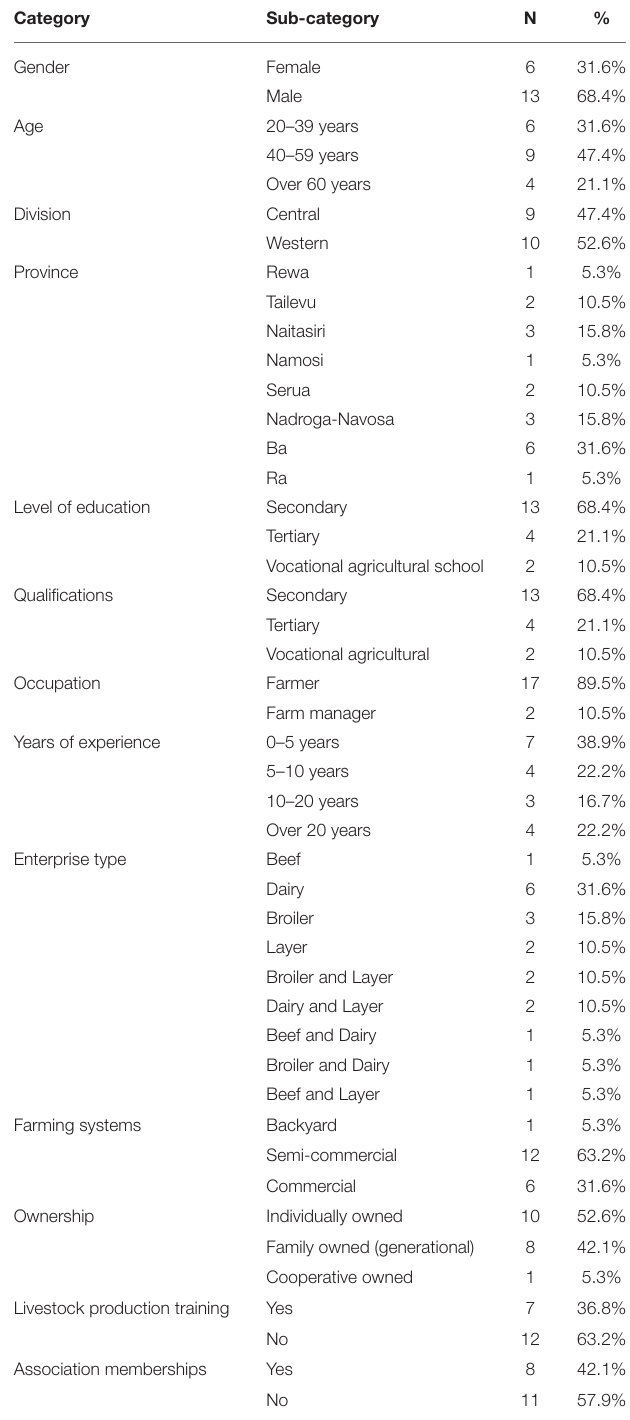
TABLE 1 | Demographic characteristics of the livestock farmers ( n = 19) from Central and Western divisions of Viti Levu * ,